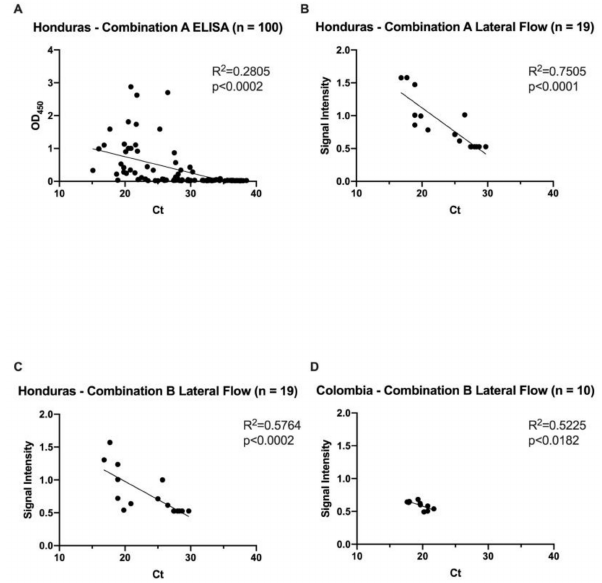
Figure 1. Chikungunya virus (CHIKV) E1 / E2-based enzyme-linked immunosorbent assay (E1 /